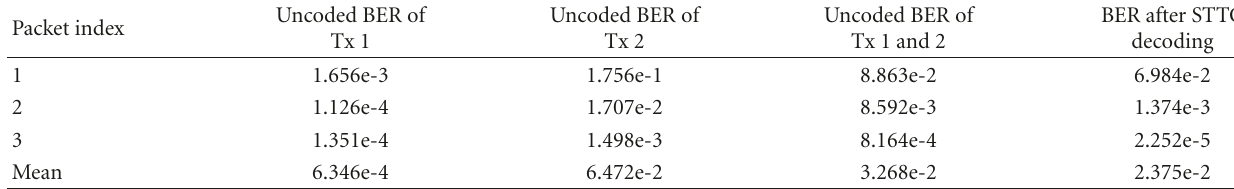
Table 2: BER of LB 2 × 8 MIMO with QPSK Modulation.